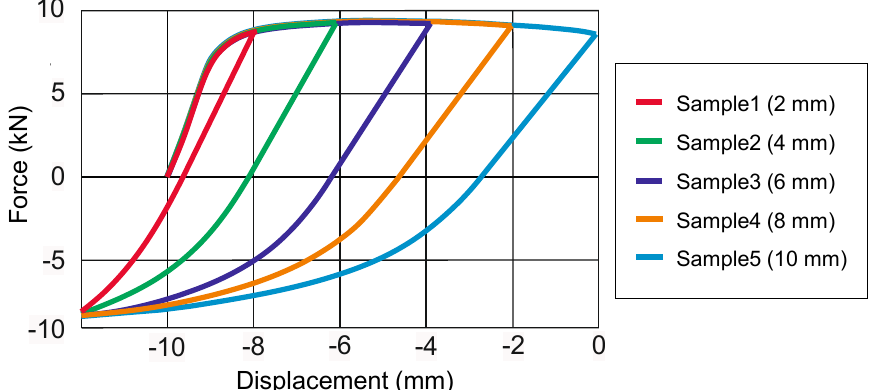
Figure 8. Experimental force-displacement curves.